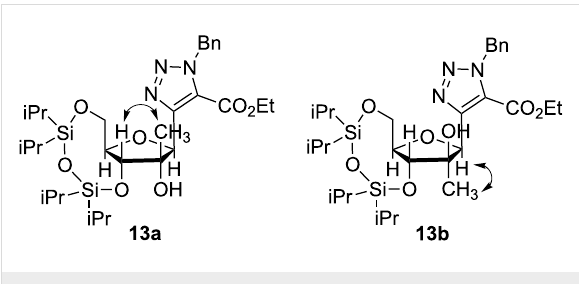
Figure 4: Structural study of isomeric compounds 13